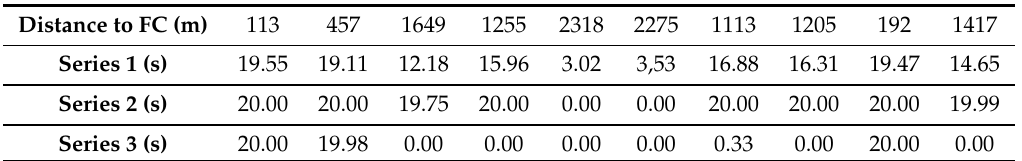
Table 5. Delay time(s) obtained for the three selected series and for 10 randomly selected distances to the fusion center (FC).